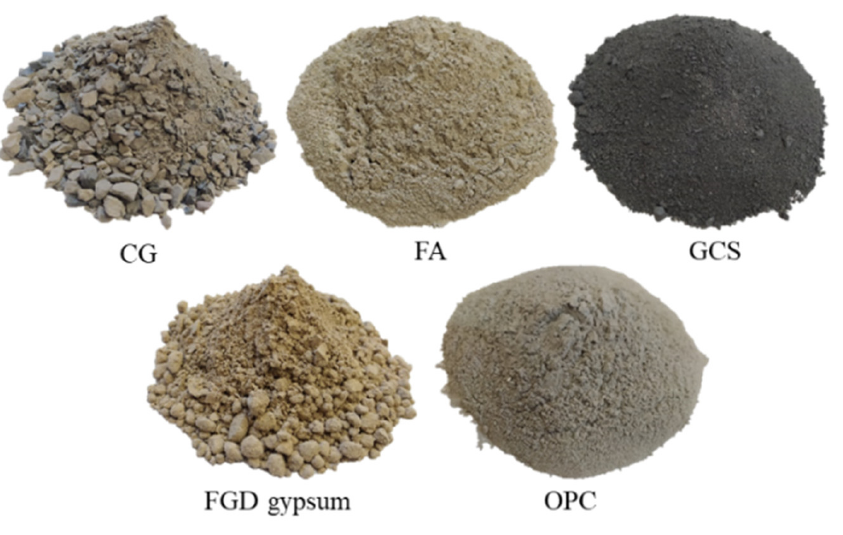
Figure 3. Experimental materials.